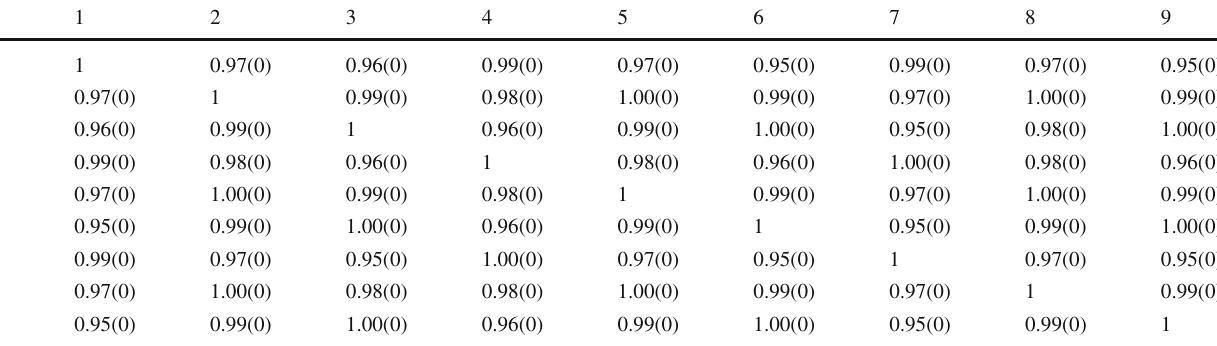
Table 8 Comparison of field theoretic definitions with GF smooth- ing and different discretizations of the topological charge operator. The numbers correspond to the numbering given in Fig. 16. We give the cor-